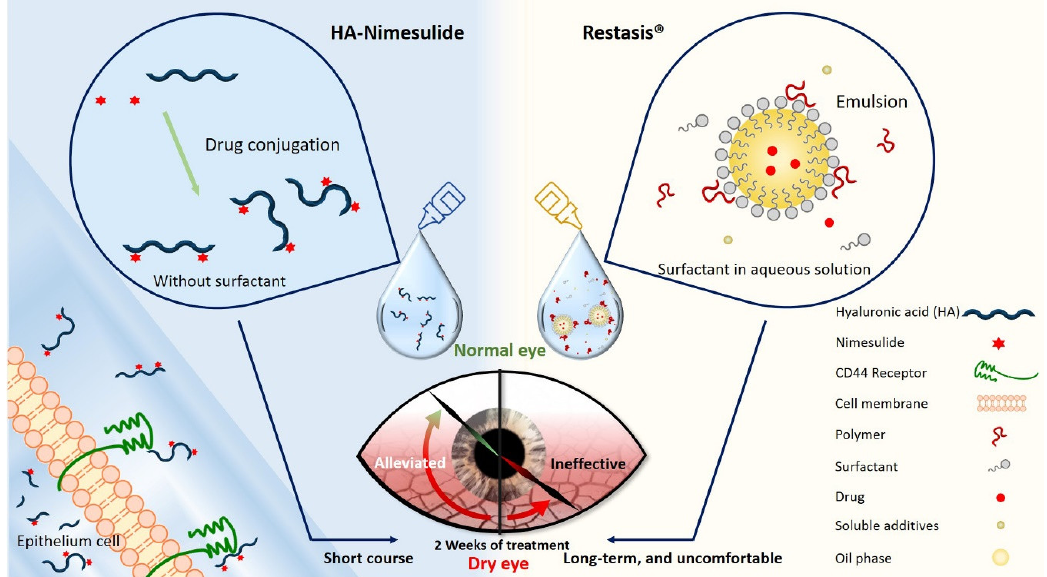
Figure 1. Schematic diagram illustrating the novel HA-nimesulide conjugate system and the standard Restasis ® to treat dry eye syndrome. The components of each formulation are depicted. HA-nimesulide has the advantage of being surfactant-free, which is thought to cause irritating eye symptoms, and improves the bioavailability of nimesulide; furthermore, CD44 receptors on the epithelial cells are targeted for greater drug retention time.